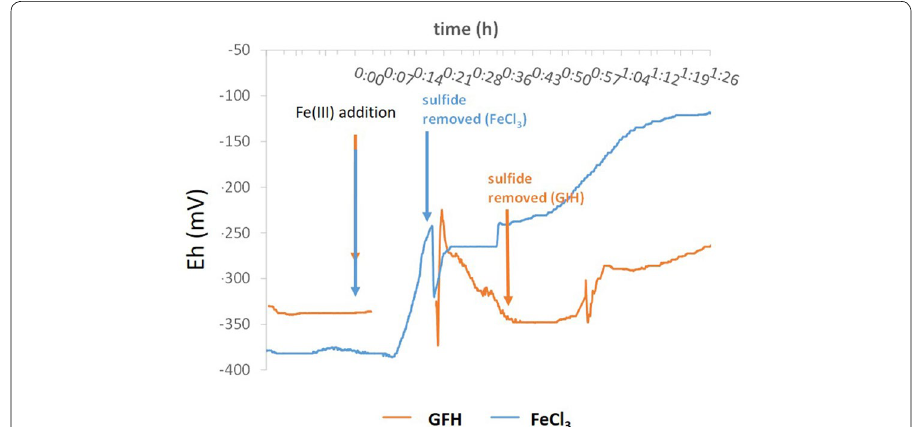
Fig. 8 Change of Eh as measured by the fluid monitoring device FluMo after filtration of the thermal water in experiment D (addition of GFH) and experiment E (addition of FeCl 3 )